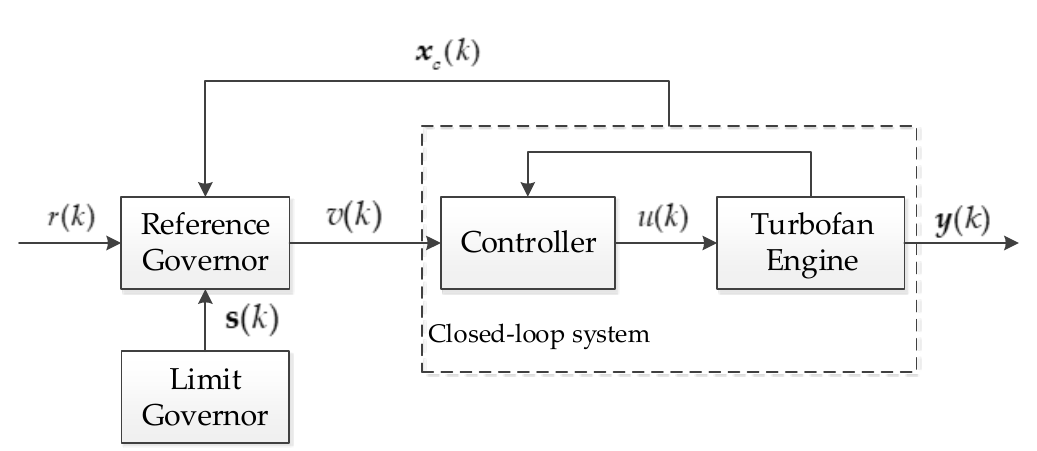
Figure 2. Structure of the novel architectures discussed in this paper.